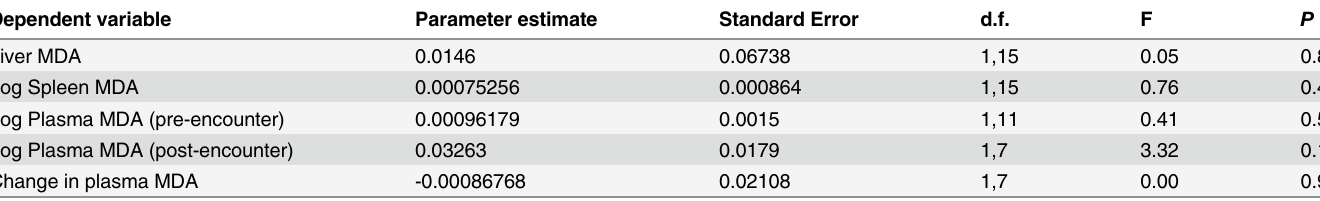
Table 4. Oxidative damage was not significantly related to biliverdin concentration in the bile. Dependent